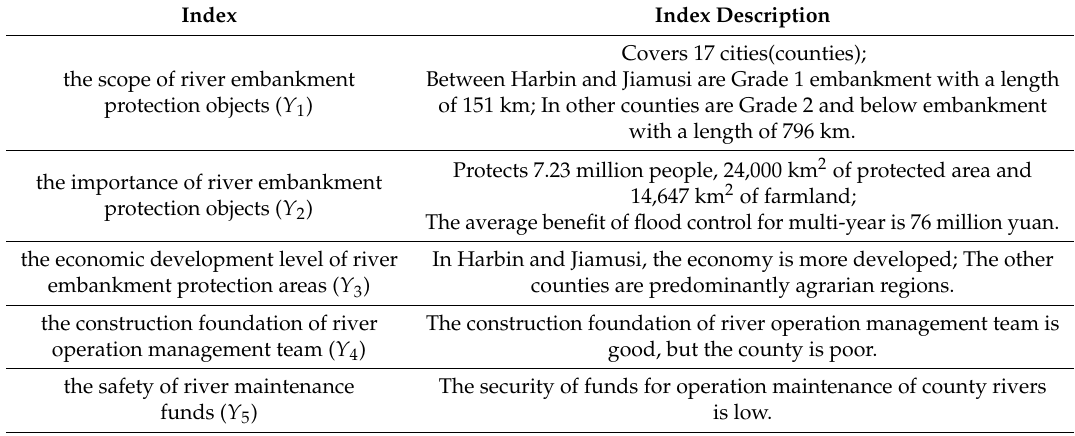
Table 6. Characteristics of the Heilongjiang section of Songhua River’s main stream.